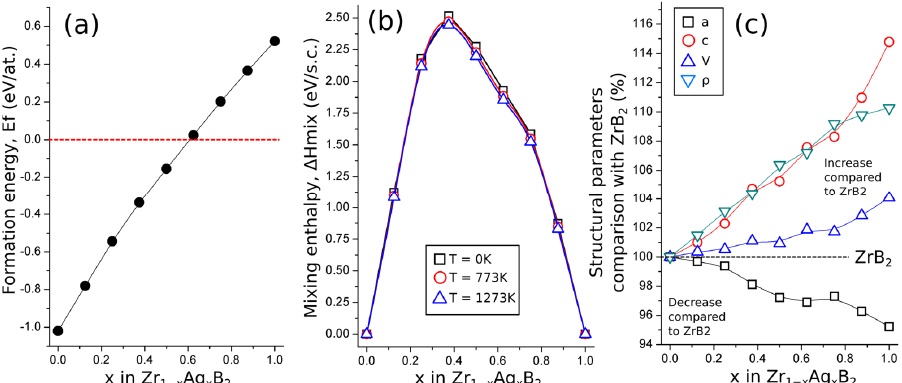
Figure 1. ( a ) Energy of formation (E f ) and ( b ) mixing enthalpy ( ∆ H mix ) of α -Zr 1 − x Ag x B 2 solid solution as a function of Ag content (x), where the red circle and blue triangle illustrate the impact of the temperature of 773 K and 1273 K on ∆ H mix , respectively. ( c ) Relative values of the hexagonal lattice parameters (a, c) with volume (V) and density ( ρ ) as a function of Ag content (x) compared with reference ZrB 2 . Table 1. Computed elastic properties of ZrB 2 and Zr 1 − x Ag x B 2 solid solutions with respect to Ag content (x). Specifically, E, G, B, ν , and H denote the elastic modulus, shear modulus, bulk modulus, Poisson’s ratio, and Vickers hardness, respectively, while B/C 44 is the machinability index, C 12 -C 66 and C 13 -C 44 are directional Cauchy pressures in the hexagonal (0001) and (10-10) directions and G/B denotes Pugh’s